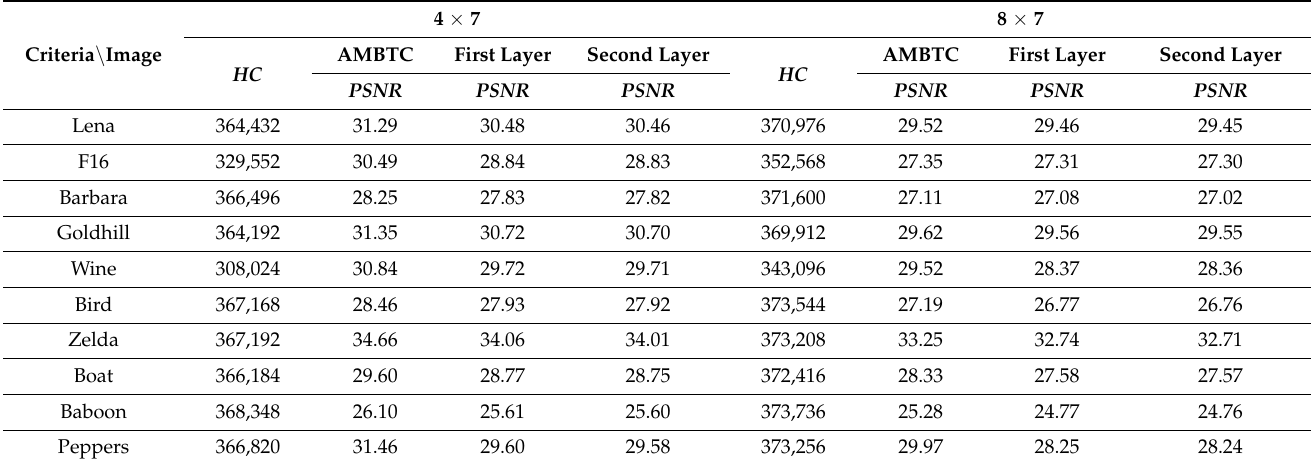
Table 5. Performance of proposed method with different block sizes (unit: dB)